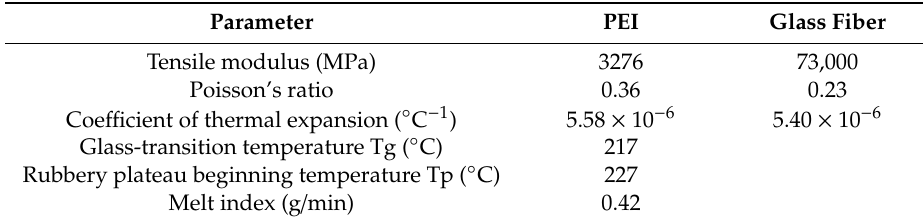
Table 1. Properties of polyetherimide (PEI) and glass fiber.